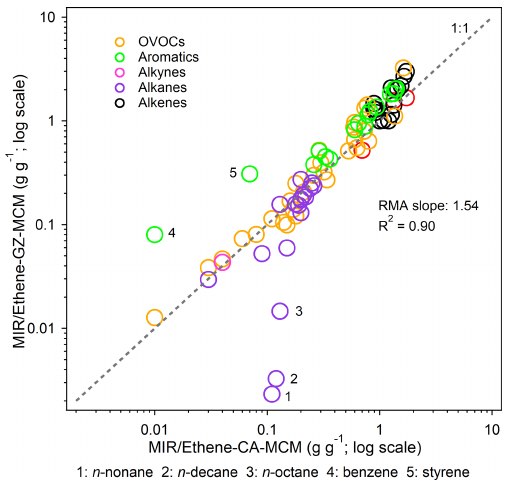
Figure 6. Comparison of the MIR/ethene (the MIR value of a given VOC divided by the MIR value of ethene) values for 79 common VOC species between Guangzhou and California. Only positively reactive VOCs are shown, and the top five VOC species with a rel- atively large reactivity value change (shown below the panel) are marked with numbers. The gray dashed line represents the 1 : 1 line. The MIR/ethene–CA-MCM data are taken from Derwent et al.